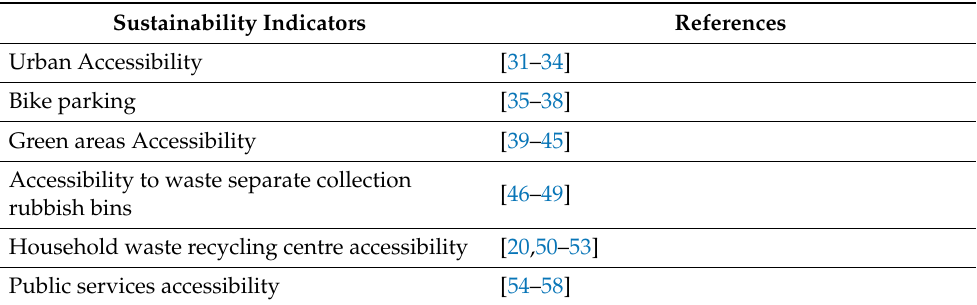
Table 3. Other references of the sustainability indicators analysed in this work.